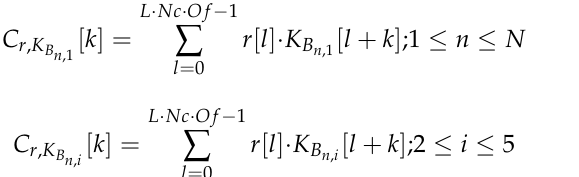
Figure 8. Example of correlation functions for U-LPS 1 when the receiver´s position is equidistant to all emitters (TDOA = 0).